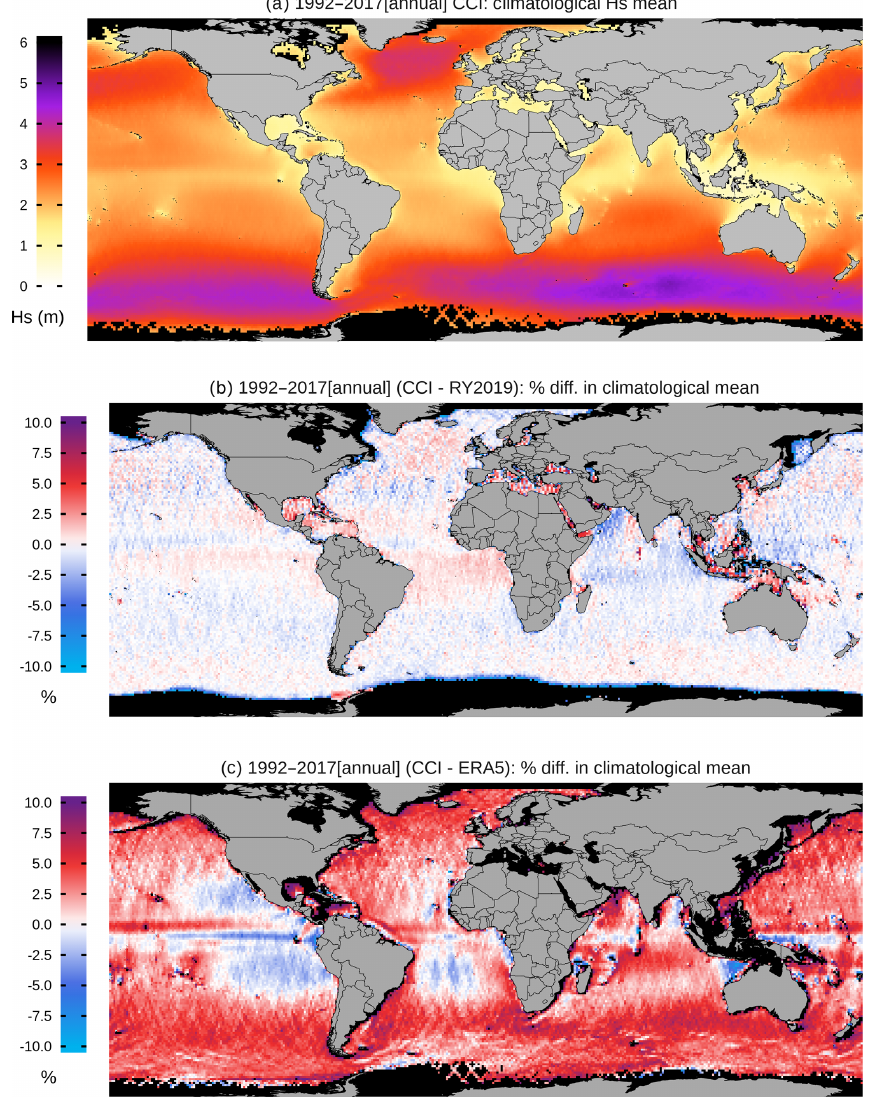
Figure 13. (a) Climatological annual mean SWH over the period 1992–2017 obtained with CCI v1 Level 4 data. (b) Normalised differ- ence (% SWH) between climatological mean from CCI and Ribal and Young (2019). (c) Normalised difference (% SWH) between the climatological mean from CCI and